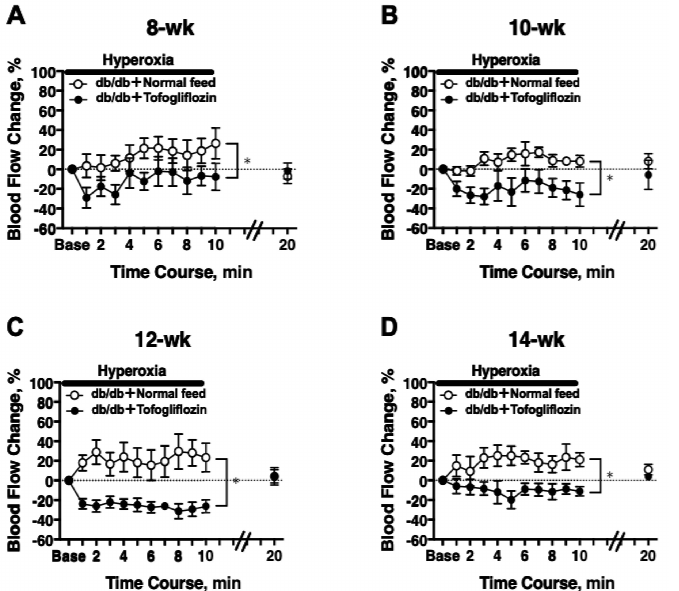
Figure 3. The RBF response to systemic hyperoxia was longitudinally retained in db/db mice treated with tofogliflozin (db/db + tofogliflozin, n = 6) and blunted in db/db mice fed normal chow (db/db + normal feed, n = 6) from 8 to 14 weeks of age: ( A ) 8 weeks of age; ( B ) 10 weeks of age; ( C ) 12 weeks of age; ( D ) 14 weeks of age. * p < 0.05 between groups analyzed by repeated-measures ANOVA; solid bar = period of hyperoxia.